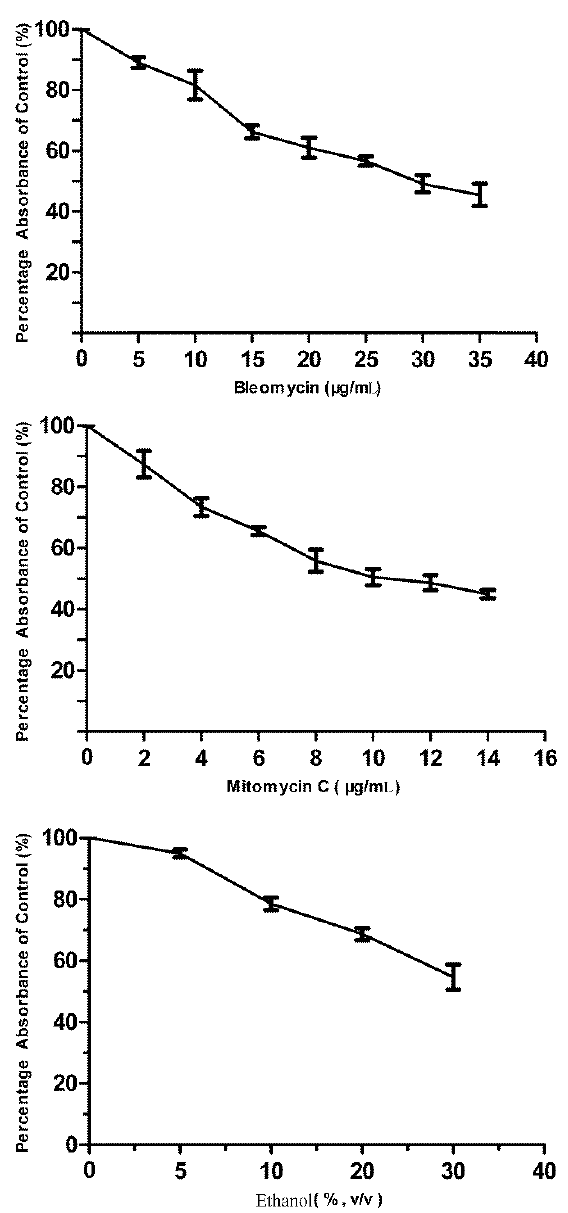
Figure 1. The cytotoxicity of bleomycin, mitomycin C and ethanol to flounder gill (FG) cells as determined by thiazolyl blue tetrazolium bromide ( MTT) assay. Data are expressed as mean ±